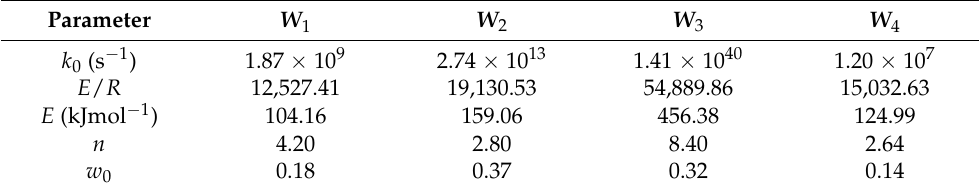
Figure 3. Fit of CPH thermal decomposition experiments under inert atmosphere. ( a ) DTG, ( b ) TG. Table 2. Kinetic parameters of CPH thermal decomposition experiments at inert atmosphere. Overall adjustments of the four heating rates.